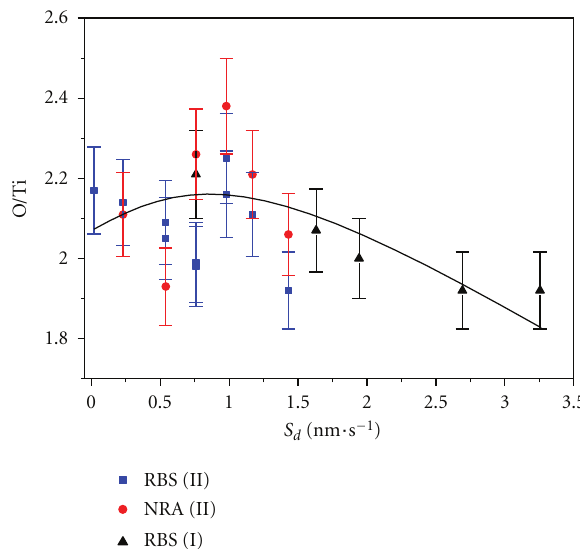
Figure 5: Atomic ratio of O/Ti, as determined by RBS and NRA, for two sets (I, II) of TiO 2 − y thin films deposited by sputtering at di ff erent growth rates S d . Sets I and II have di ff erent film thickness, I: 100–130 nm, II: 30–60 nm. The solid line is a guide to the eye.